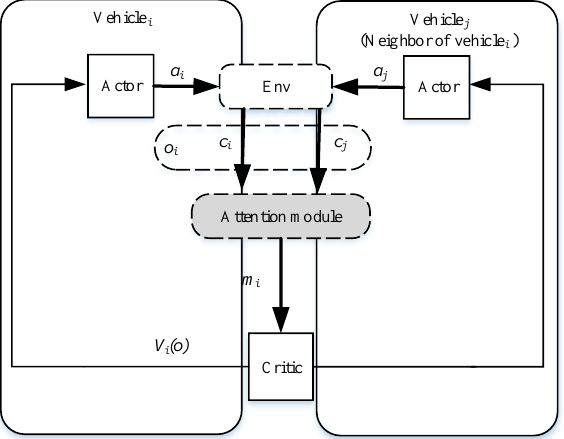
Figure 3. The framework of the proposed Attn-MAPPO algorithm.